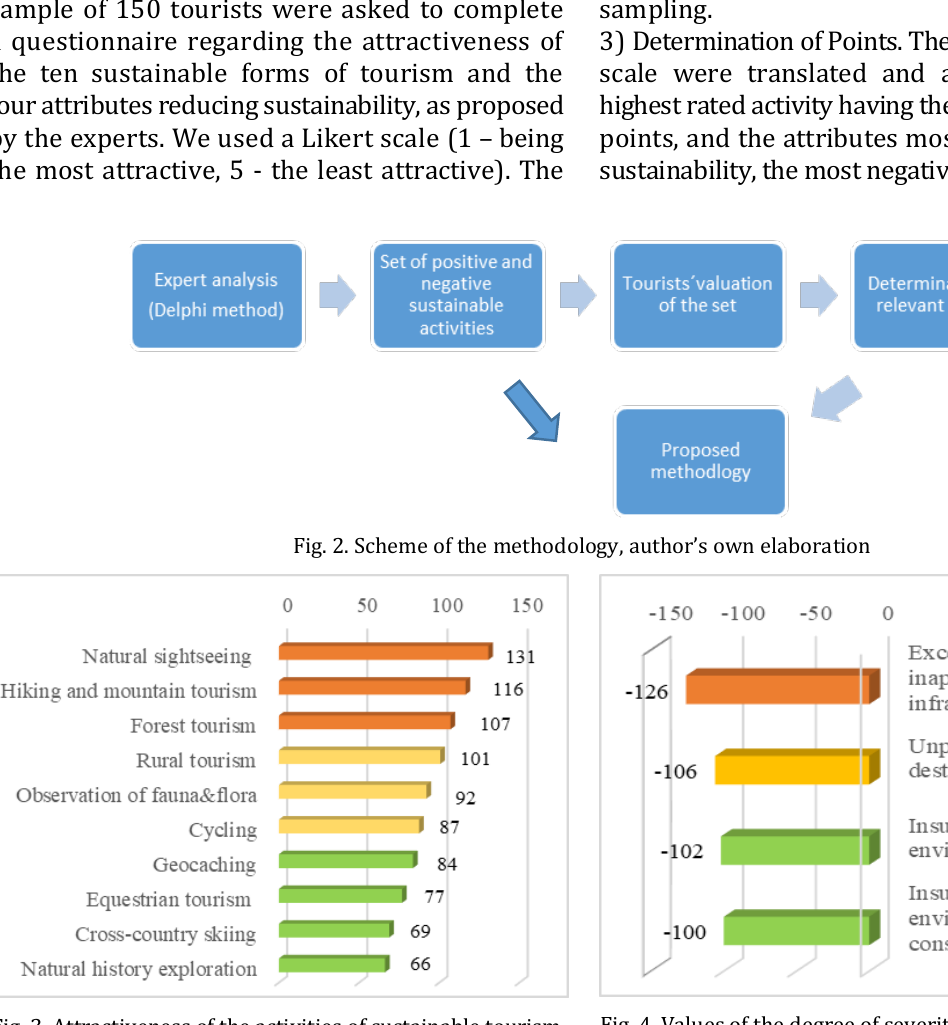
Fig. 3. Attractiveness of the activities of sustainable tourism for visitors, author’s own elaboration